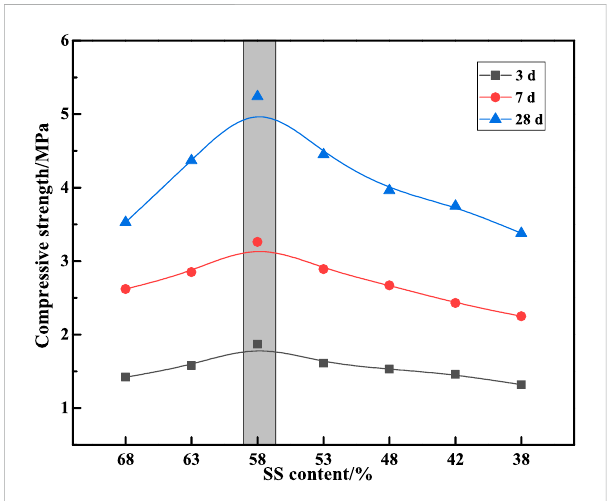
FIGURE 5 Effect ofcontent ofSSonthemechanicalpropertiesofBFPBM at different curing ages.